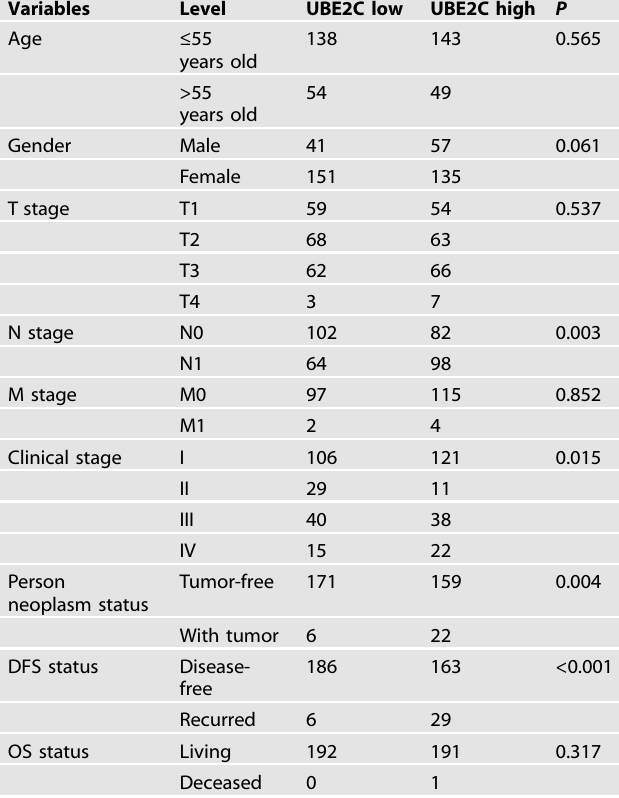
Table 1. The clinical characteristics of THCA